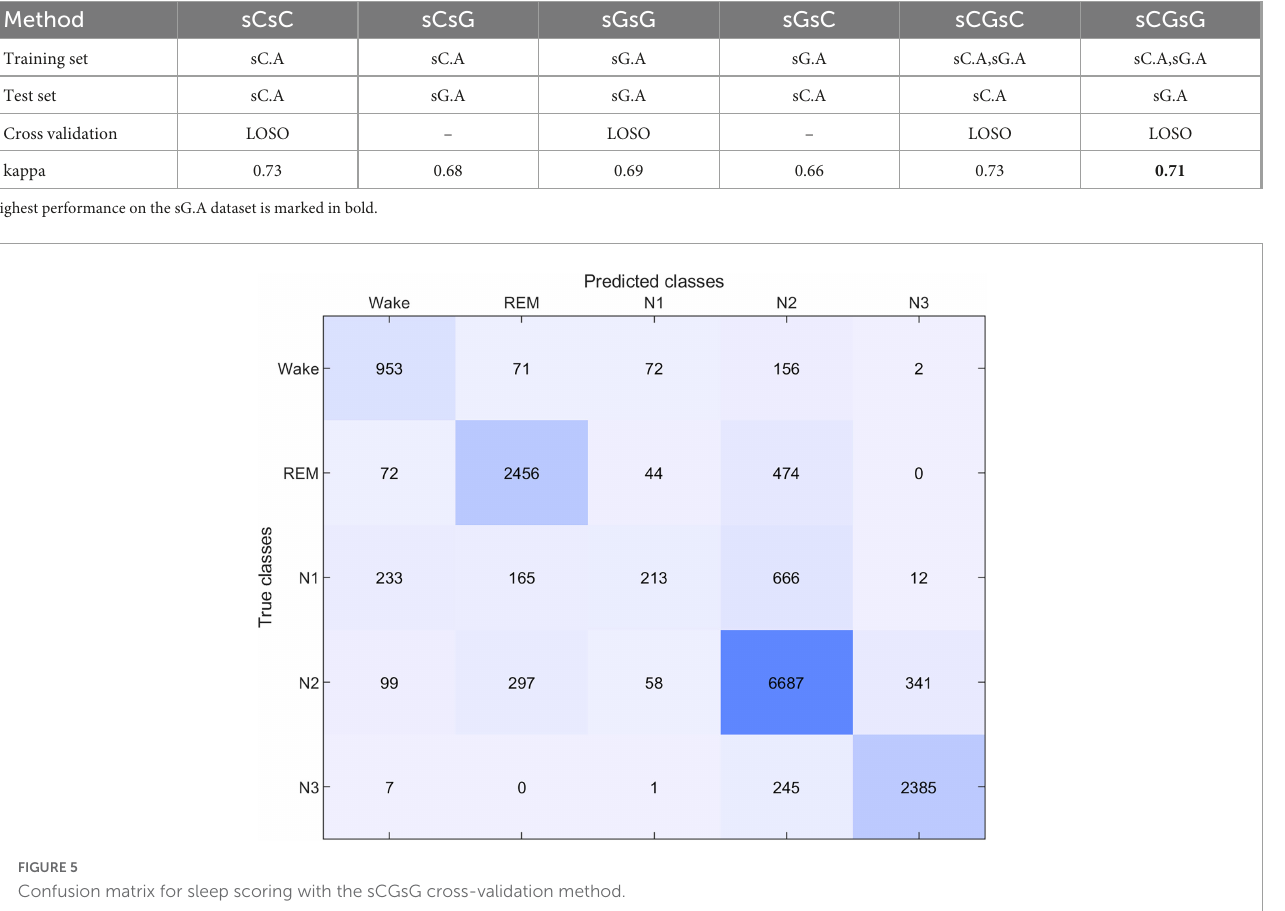
TABLE 1 The kappa values for each train-test pair together with the applied cross validation method.